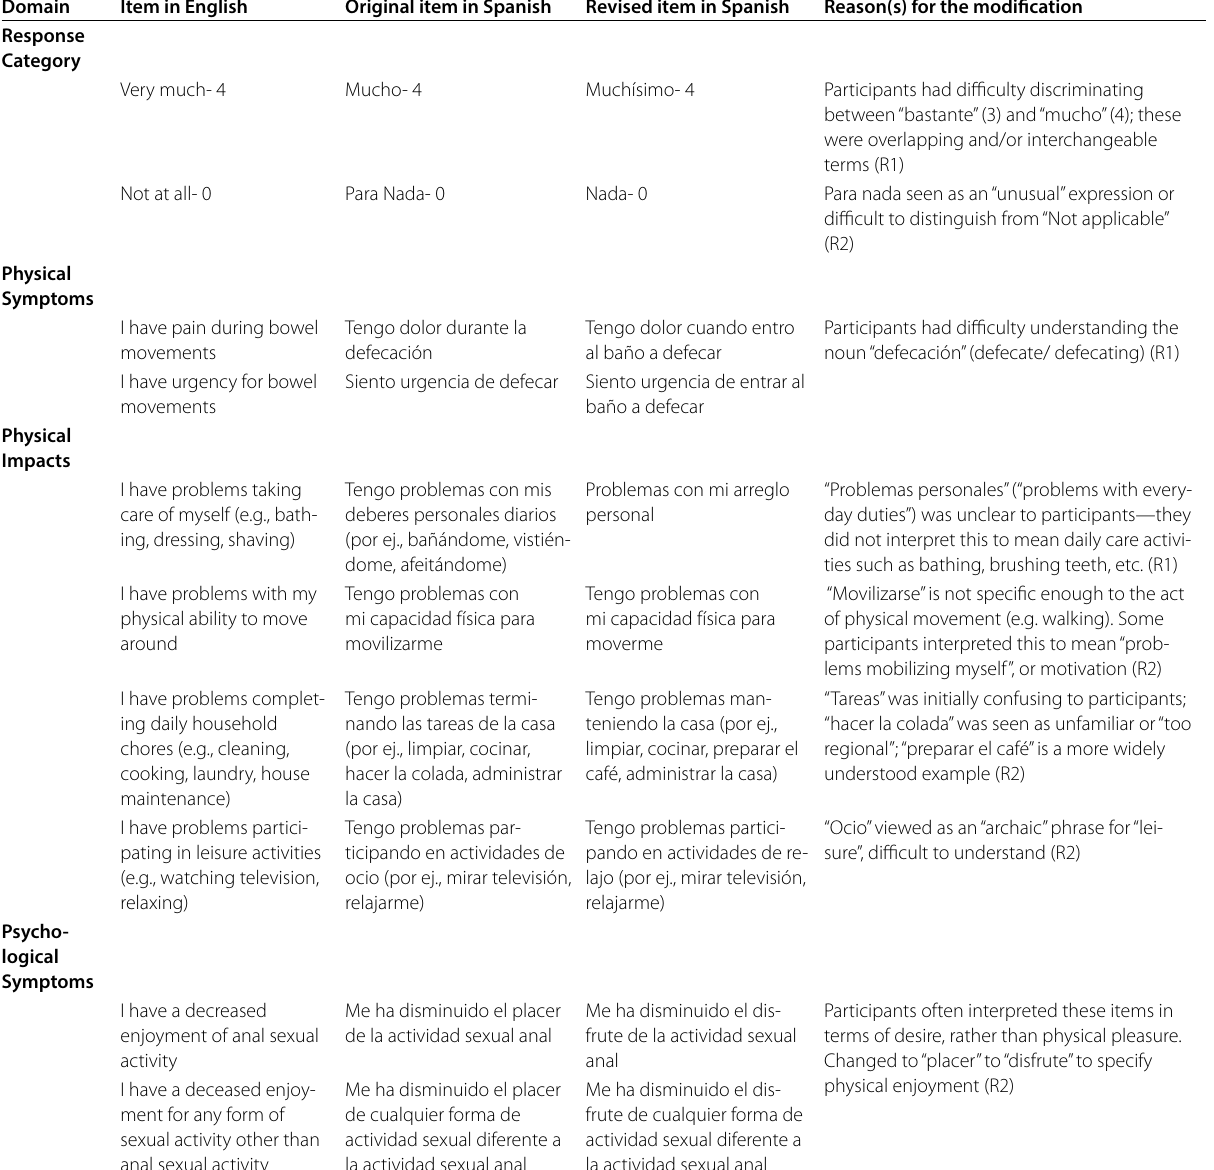
Table 2 Spanish A-HRSI modified terms and reasons for modifications